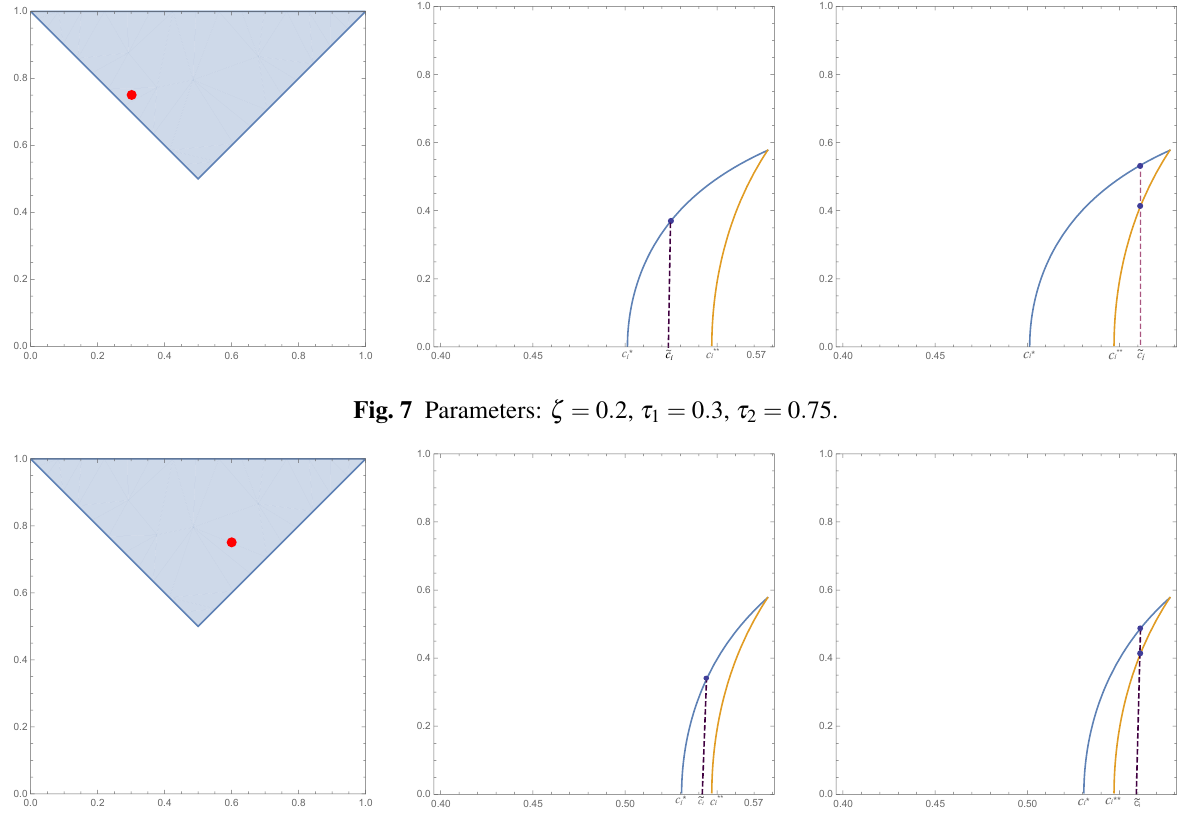
Fig. 8 Parameters: ζ = 0 . 2, τ 1 = 0 . 6, τ 2 = 0 .